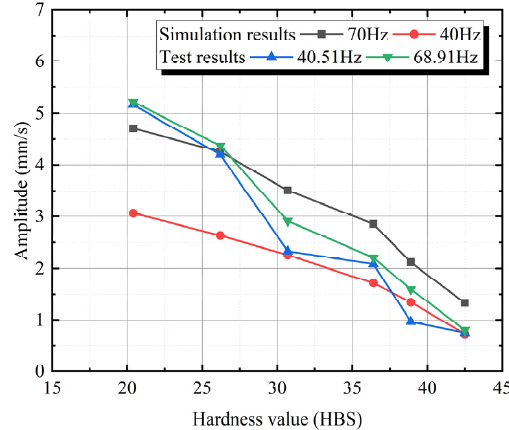
Figure 21. Hardness affects horizontal vibration .